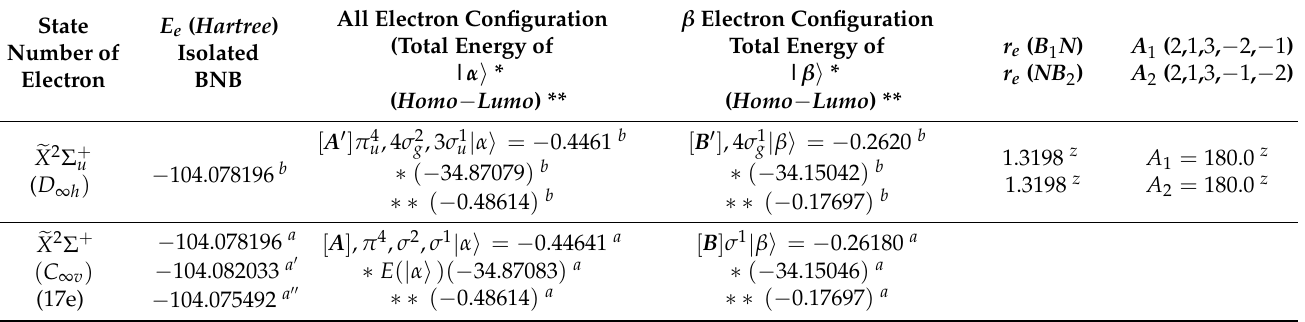
Table 2. Geometry optimization and electrical properties of B 2 N ( − ,0, +) in ground and excited